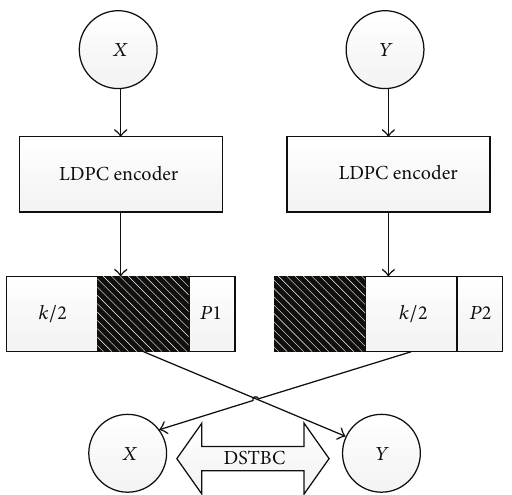
Figure 3: The intracluster communication process of a CG.